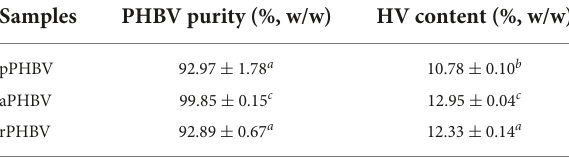
TABLE 2 Purity and composition of PHBV extracted from the wasted bread/seawater substrate with different methods ( Figure 1 ): pPHBV, sample obtained from the CHCl 3 :H2O separation and the precipitation with cold ethanol; rPHBV, obtained by the replacement of the CHCl 3 :H 2 O separation with repeated washing with water; aPHBV, obtained by the replacement of the CHCl 3 :H 2 O separation with repeated washing with water, but followed by solubilization in CHCl 3 and purification with cold ethanol.